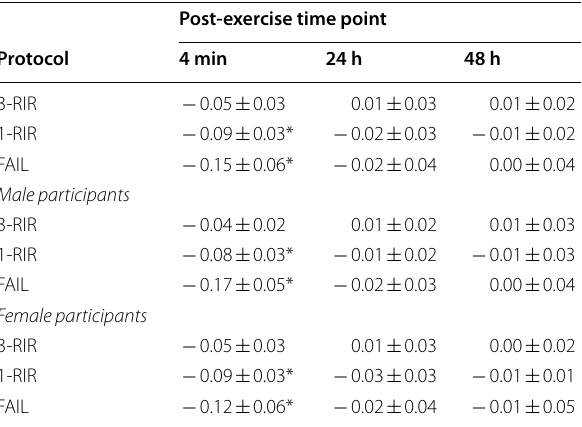
Table 3 Mean decreases in lifting velocity from pre-exercise to